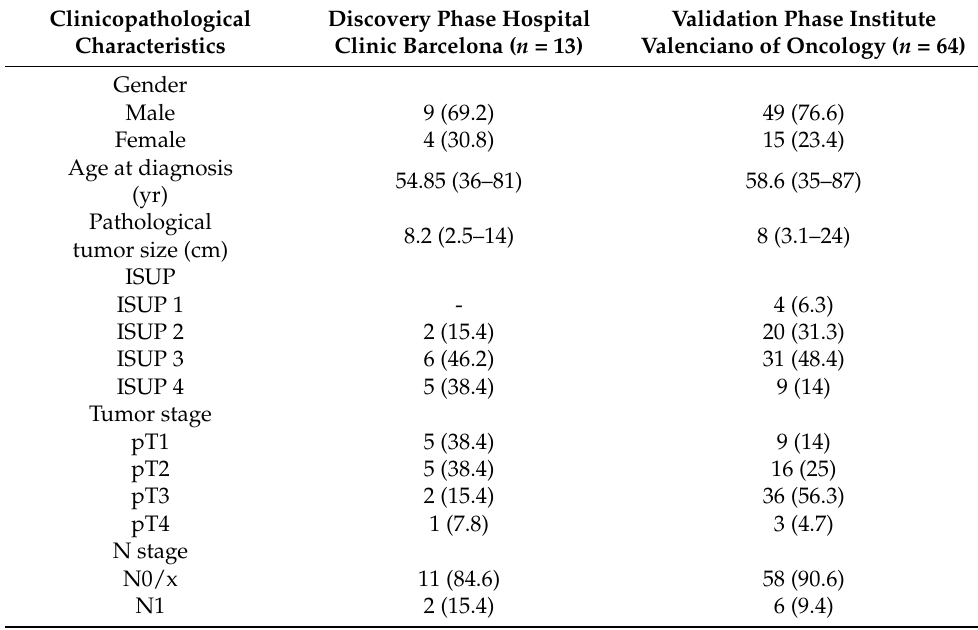
Table 1. Demographic and pathological characteristics of enrolled